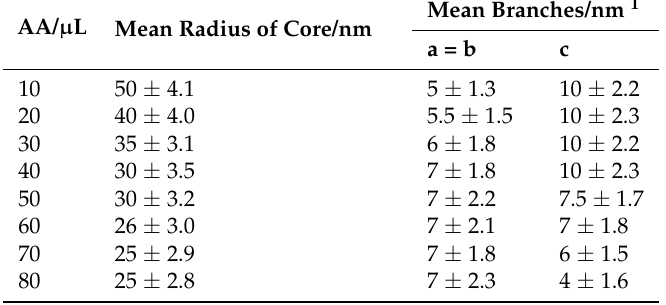
Figure 2. TEM images of the AuNBr synthesized with different amounts of AA volumes: ( a ) 10 μ L; ( b ) 20 μ L; ( c ) 30 μ L; ( d ) 40 μ L; ( e ) 50 μ L; ( f ) 60 μ L; ( g ) 70 μ L and ( h ) 80 μ L.